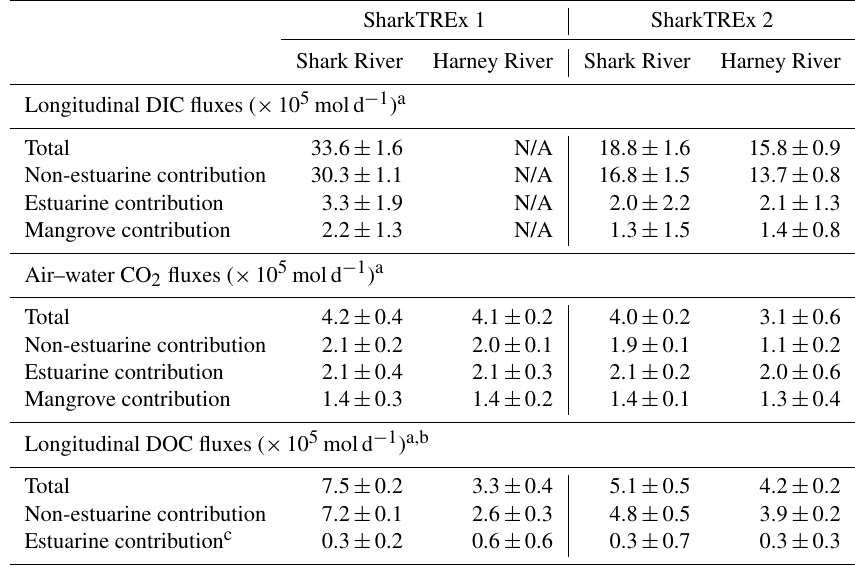
Table 2. Longitudinal DIC and DOC fluxes, and air–water CO 2 fluxes for the Shark and Harney rivers during SharkTREx 1 and